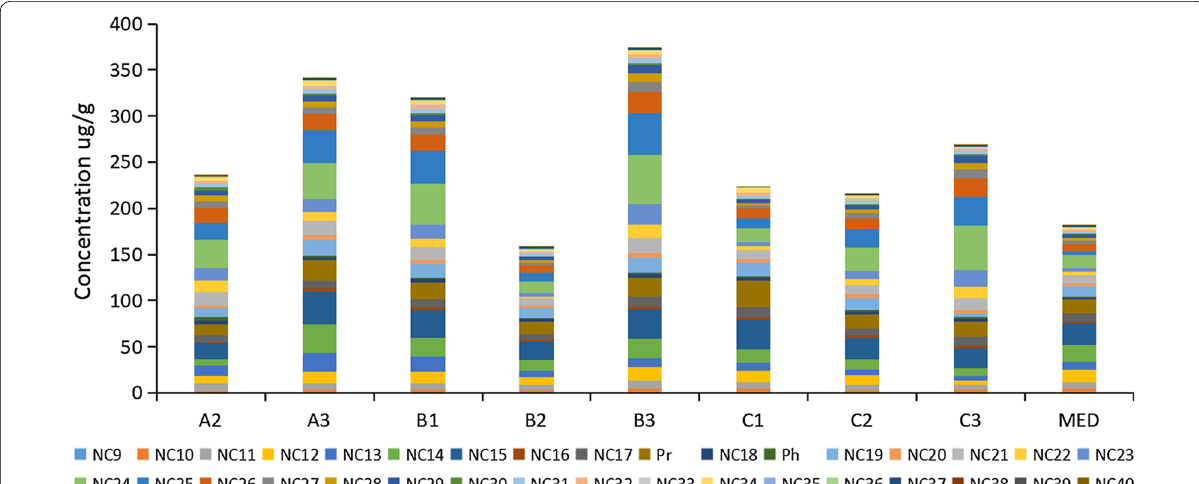
Fig. 3 The abundance of n -alkanes in sampling sediment analysis by GC–MS. The symbol An (Bn, Cn): the nst sampling site of line A (B, C); MED: control site in Jiaozhou Bay; SLR: control site in Shilaoren Beach, which was outside of Jiaozhou Bay. Internal standards were determined using n -tetracosane-D50 (10 μg/mL). The abundance of each n-alkane was calculated by the internal